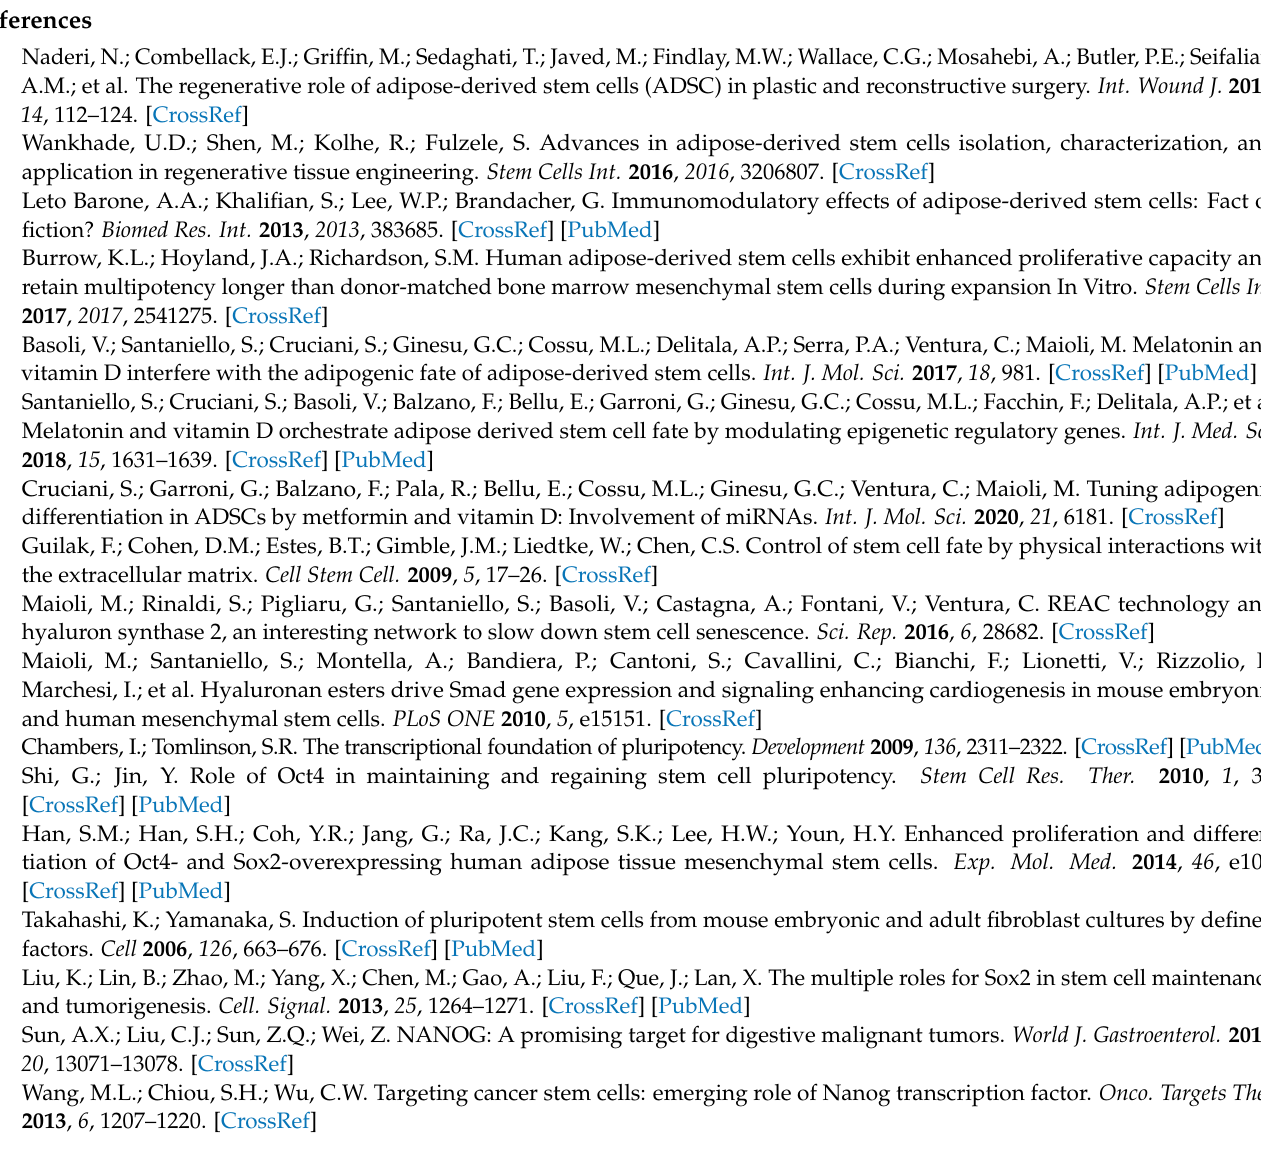
Table S1: Calibration curves, Figure S2: Calibration curve and medium